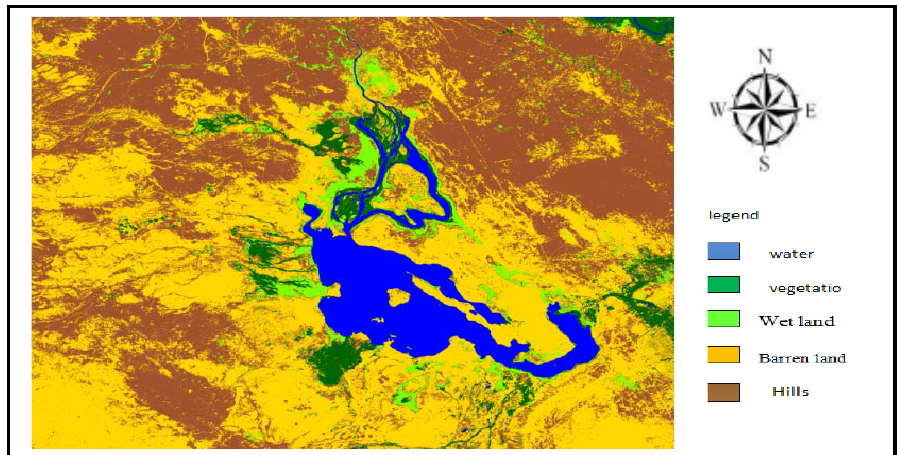
Fig.15: Supervised classification using Maximum Likelihood classifier method for Landsat-7 (1999).